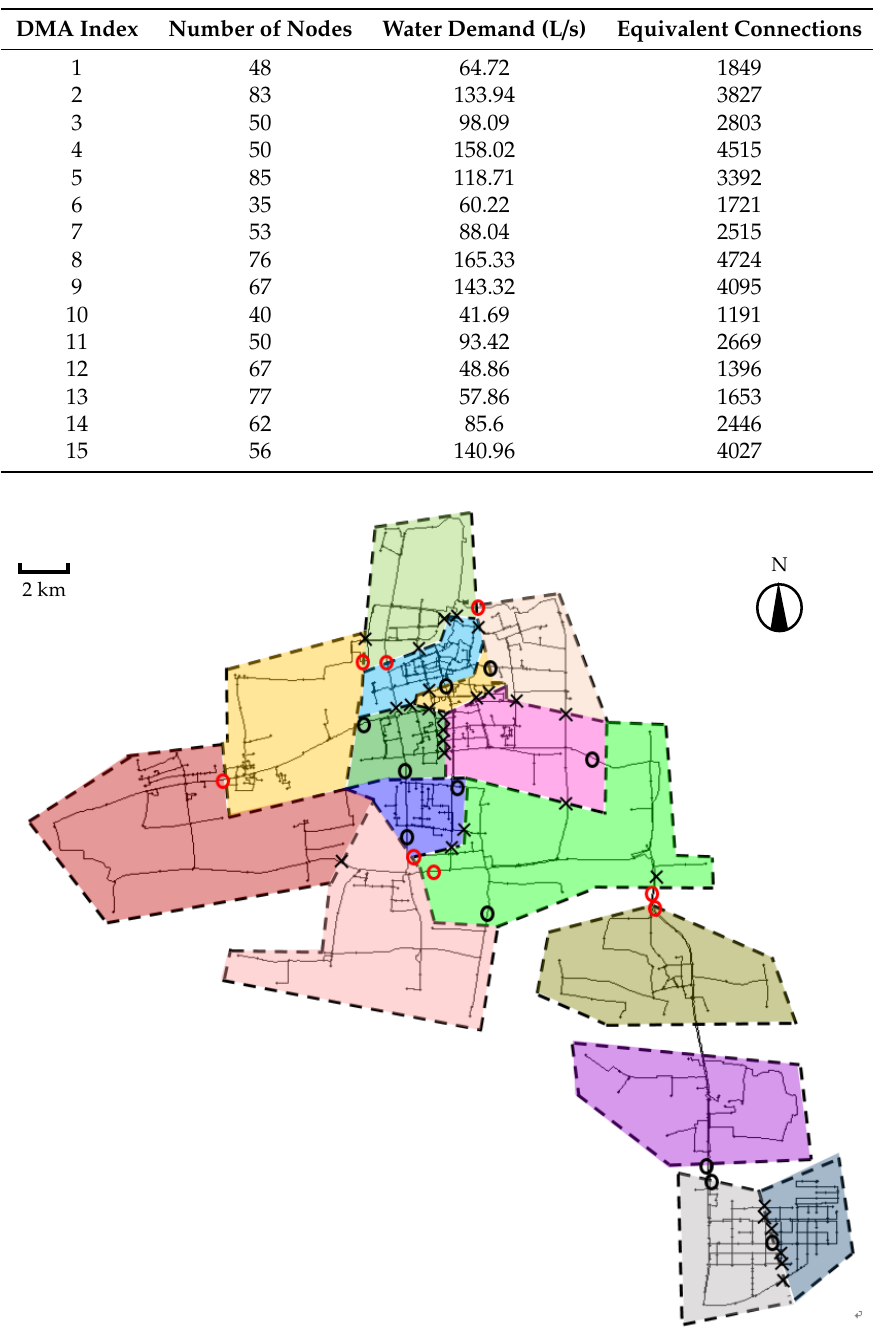
Figure 4. Final DMA configuration of H town.